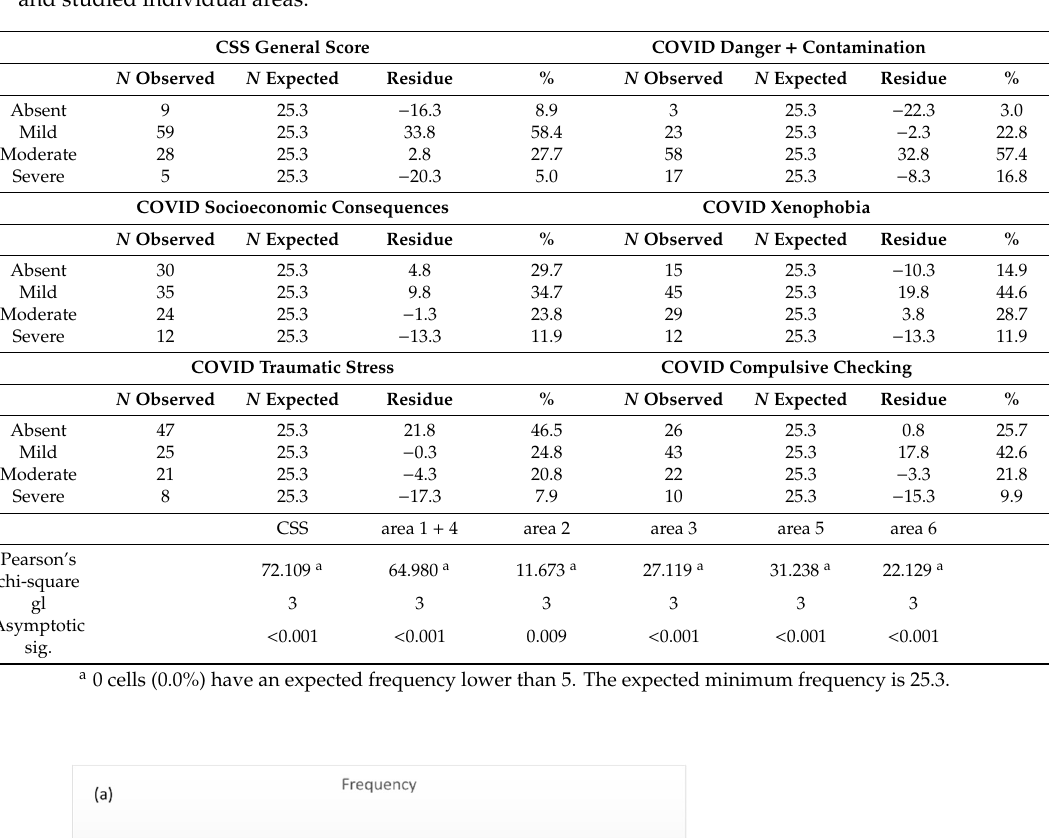
Table 2. COVID-related stress frequency for healthcare providers correlated to the general CSS and studied individual areas.